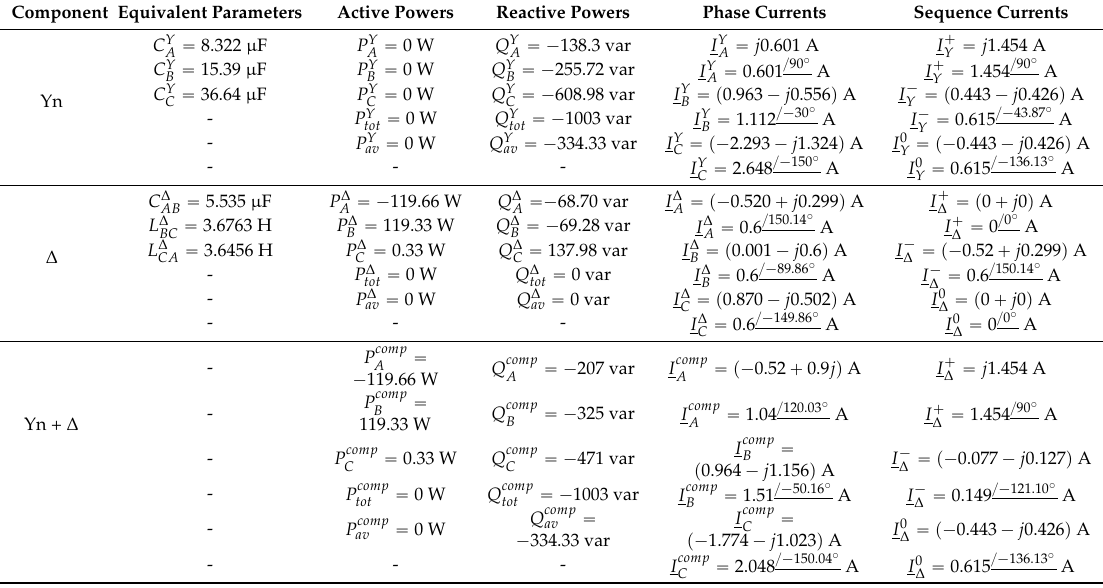
Table 2. The unbalanced compensator sized by the “classical” method (Balancing Reactive Compensator